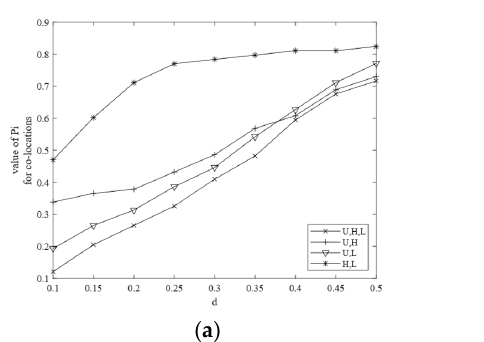
Figure 9. ( a ) Pr of co ‐ location (cid:4668)𝑈 , 𝐻 , 𝐿(cid:4669) ; ( b ) Pr of co ‐ location (cid:4668)𝑈 , 𝐻 , 𝑁(cid:4669) ; ( c ) Pr of co ‐ location (cid:4668)𝑈 , 𝐻 , 𝑀(cid:4669) ; ( d ) Pr of co ‐ location